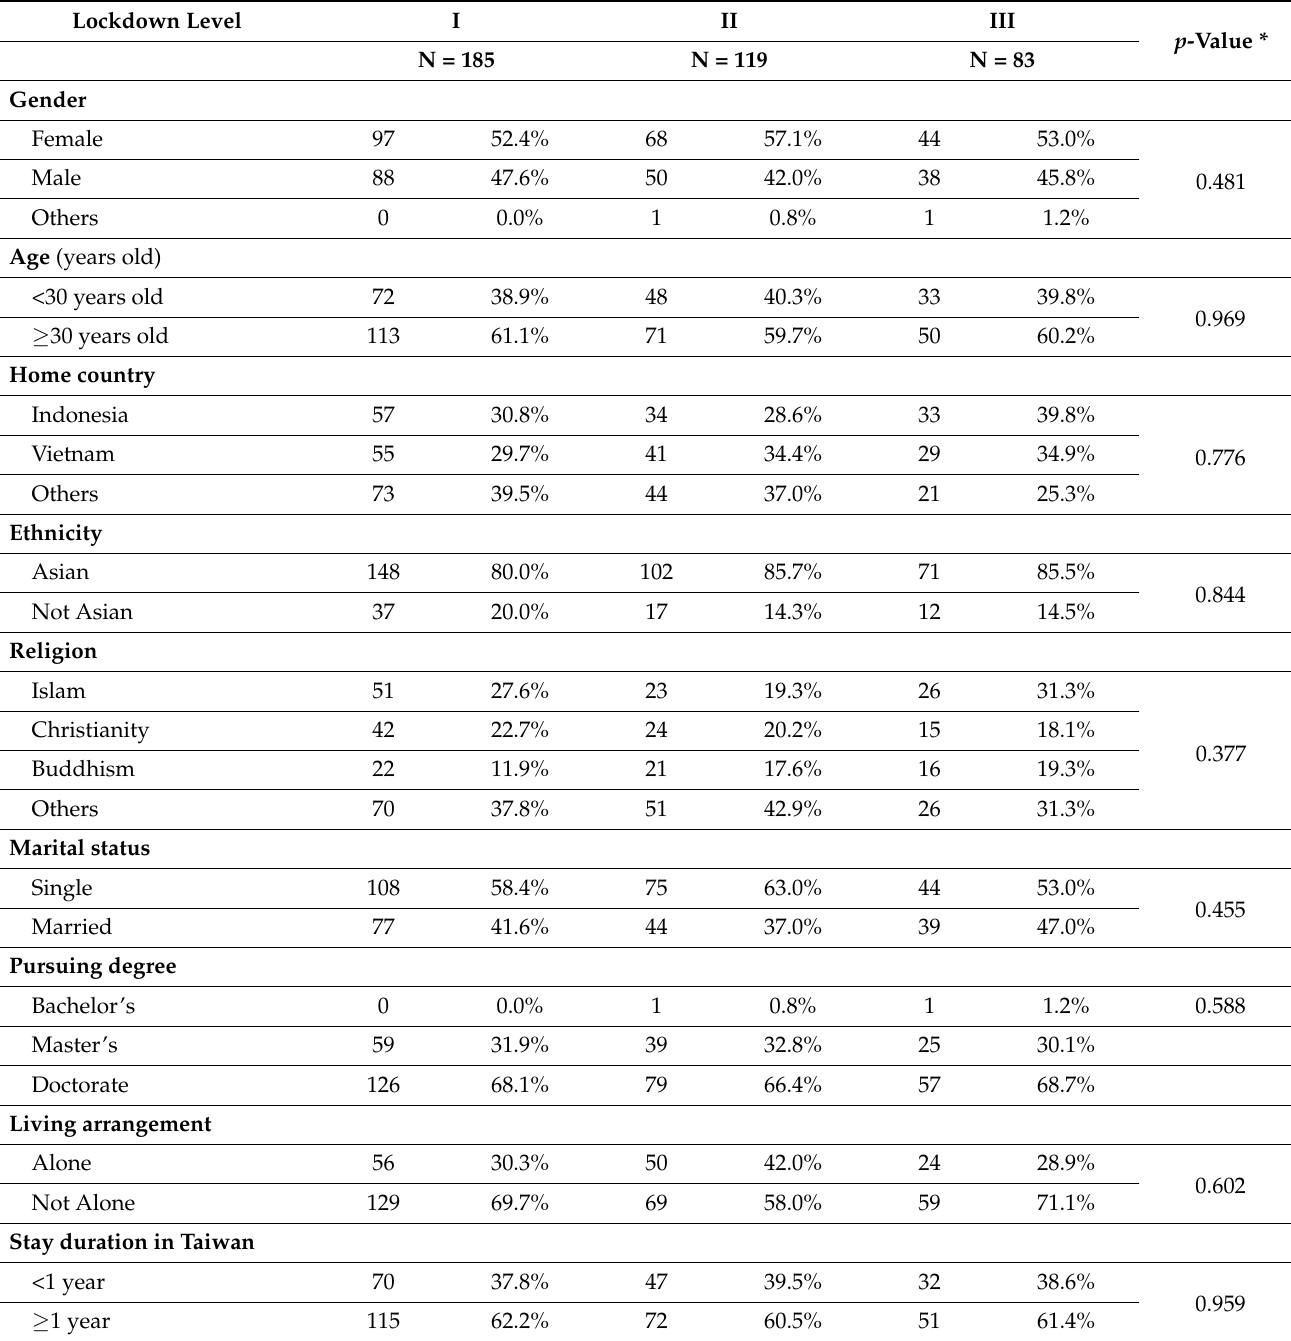
Table 2. Demographic information of